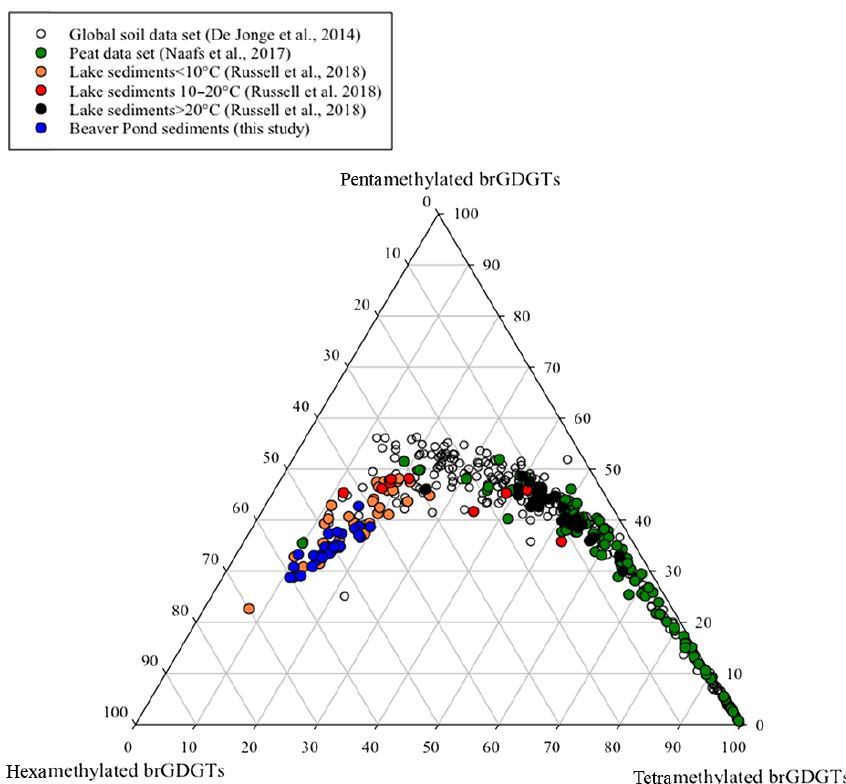
Figure 3. A ternary plot illustrating the fractional abundances of the tetra- (Ia–c), penta (IIa–c and II (cid:48) a–c) and hexamethylated (IIIa–c and III (cid:48) a–c) brGDGTs. The global soil data set (open circles; De Jonge et al., 2014), the global peat samples (green circles; Naafs et al., 2017) and lake sediments from East Africa (black circles indicate samples from lakes > 20 ◦ C, red circles indicate samples from lakes between 10 and 20 ◦ C and orange circles designate samples from lakes < 10 ◦ C; Russell et al., 2018) are included for comparison with the Beaver Pond sediments (blue circles; this